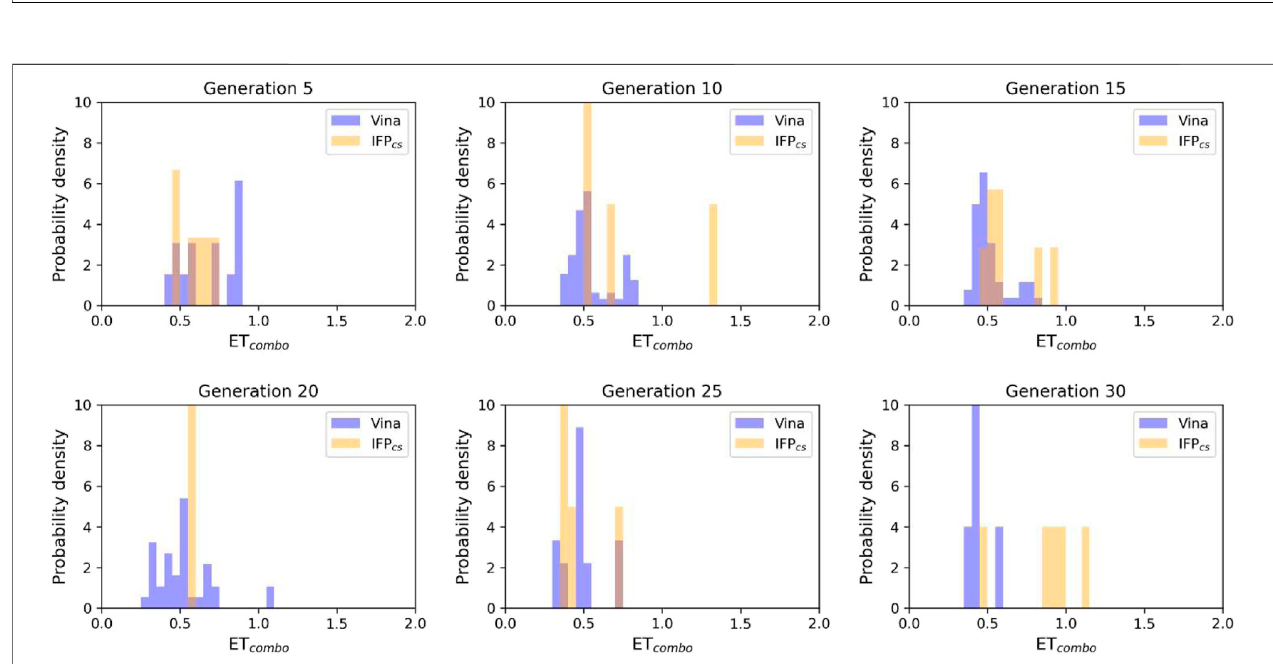
FIGURE5| TheabilityofthetwoAutogrowprotocolsinthebenchmark denovo runtoproducecompoundsthathaveahighdegreeofsimilarity concerningshape and electrostatic properties to the crystallographic ligands, chosen as reference. The probability distribution of the ET combo score for compounds populating each generation is reported as a histogram, where the vertical axis reports the probability density while the horizontal axis reports the ET combo value. Two distributions are reported within each plot: the blue bars refer to compounds generated with the VINA protocol, while the orange bars refer to compounds generated with the IFP CS